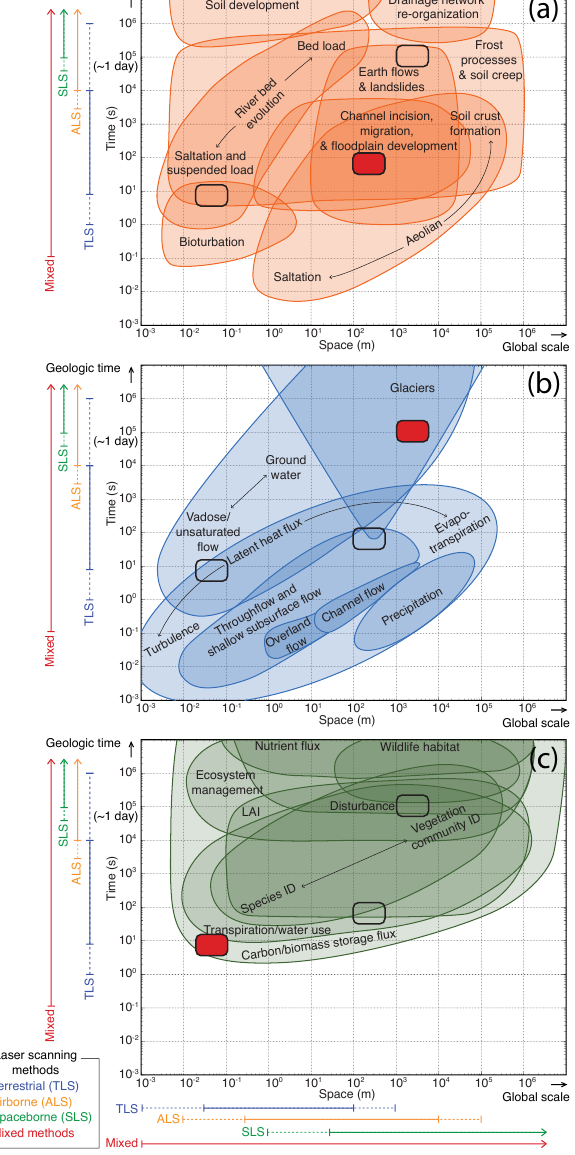
Figure 1. Important CZ processes graphed as a function of time ver- sus space for geomorphology (a) , hydrology (b) , and ecology (c) . The spatial and temporal scales that lidar is currently addressing are shown as colored bars, with dotted bars indicating increasing reso- lutions and larger extents available in the next 5 years. Overlapping spatiotemporal scales that encompass the example questions in the Fig. 3 are also noted with red boxes.